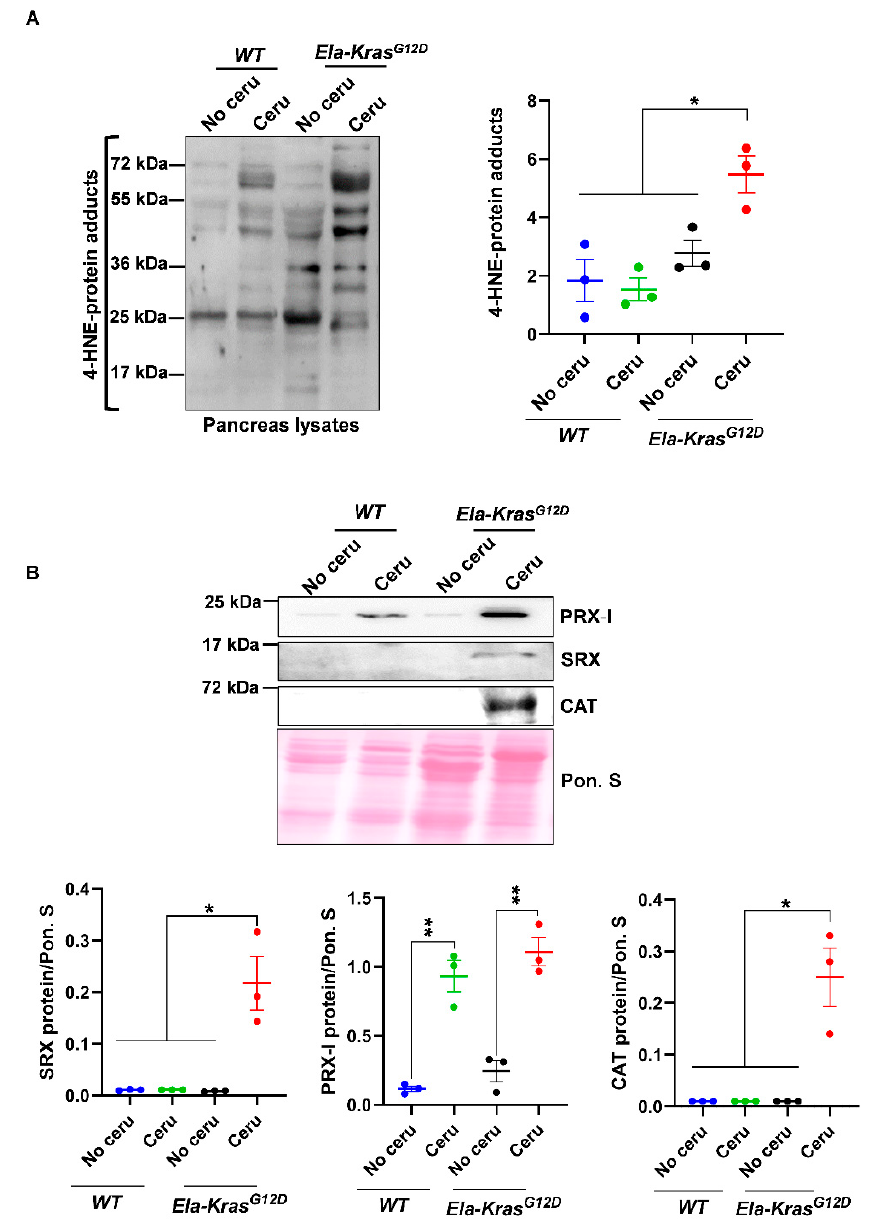
Figure 1. Pancreatitis induces an important pro-oxidant response particularly in Ela-Kras G12D mice. ( A ) Western blot for the oxidative damage marker, 4-HNE, on pancreas lysates of wild-type ( WT ) and Ela-Kras G12D mice treated with cerulein for 5 days ( n = 3 for both WT and Ela-Kras G12D ) or untreated ( n = 3 for both WT and Ela-Kras G12D ). The corresponding densitometry analysis is also available as a bar graph. ( B ) Western blot on pancreas lysates of wild-type ( WT ) and Ela-Kras G12D mice treated with cerulein for 5 days ( n = 3 for both WT and Ela-Kras G12D ) or untreated ( n = 3 for both WT and Ela-Kras G12D ). The analyzed enzymes are Peroxiredoxin-I (PRX-I), Sulfiredoxin (SRX) and Catalase (CAT). The corresponding densitometry analysis normalized to Ponceau S staining (Pon. S) is also available as a bar graph. Data are mean ± SEM. Statistical significance for all panels in this figure was tested by one-way ANOVA test and further interactions were analyzed by post hoc test (* p < 0.05; ** p < 0.01). All quantifications in this figure show biological